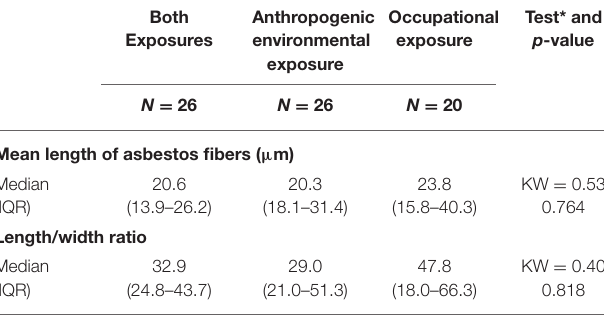
TABLE 2 | Dimensional characteristics of asbestos according to the cause of death.